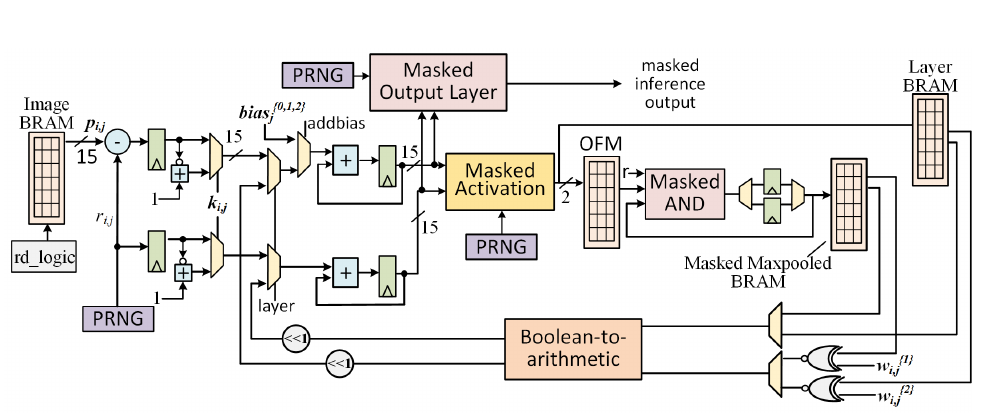
Figure 14: Hardware design of masked